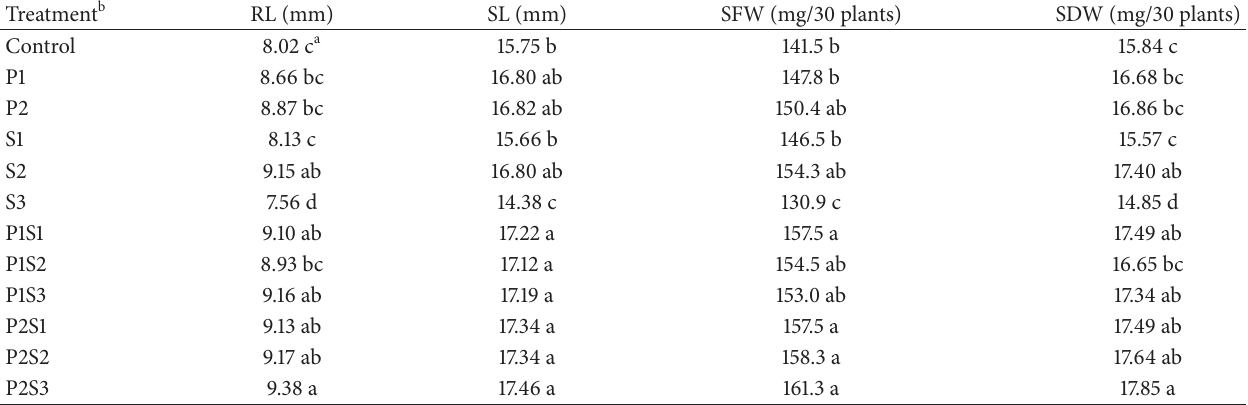
Table 4: Effects of coating agents on seedling growth of Honghuadajinyuan (HHDJY) under drought stress.